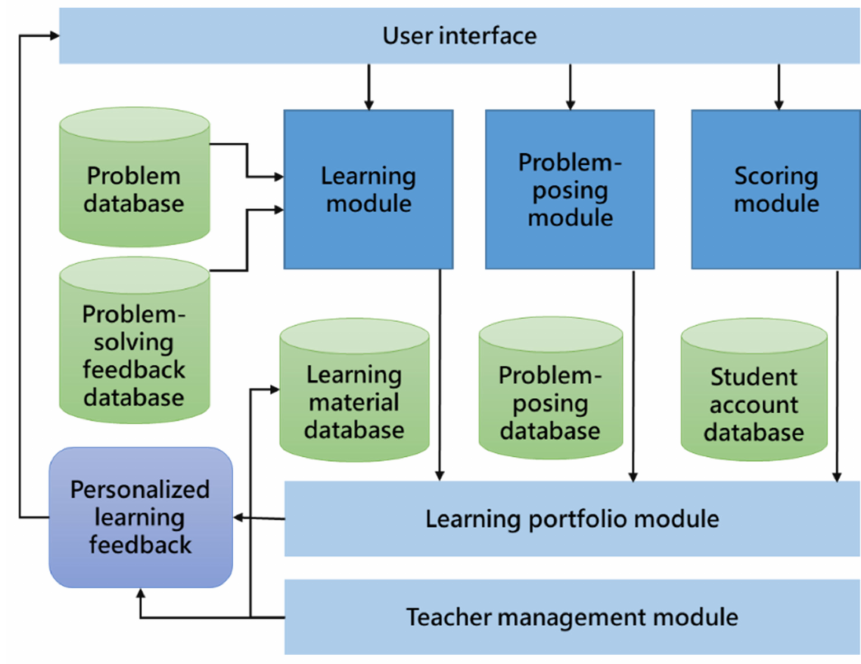
Figure 1. System